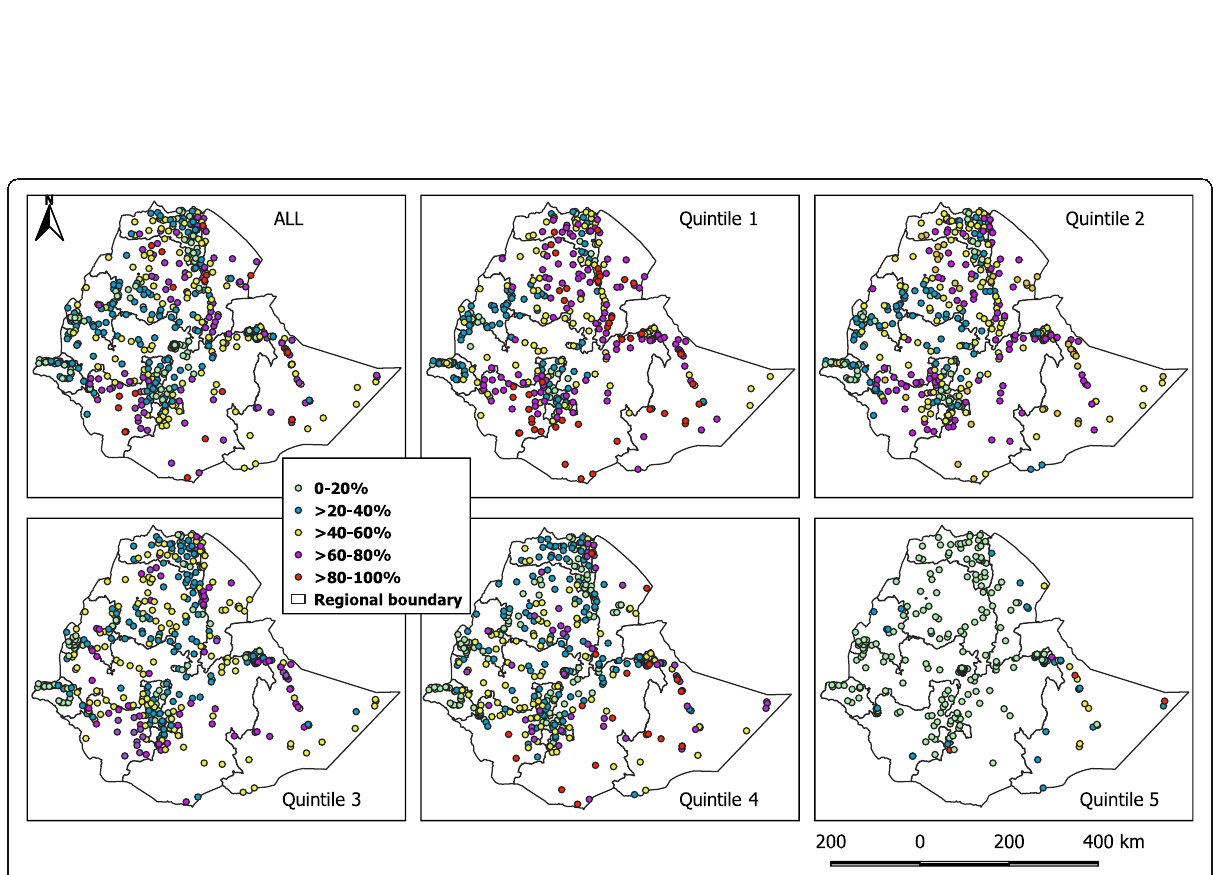
Fig. 5 Clusters categorized by the spatially smoothed coverage rates of unimproved water for the overall population and by each quintile. The percentage of unimproved water coverage was high in the North, South, and East with a clear pattern after the spatial smoothing